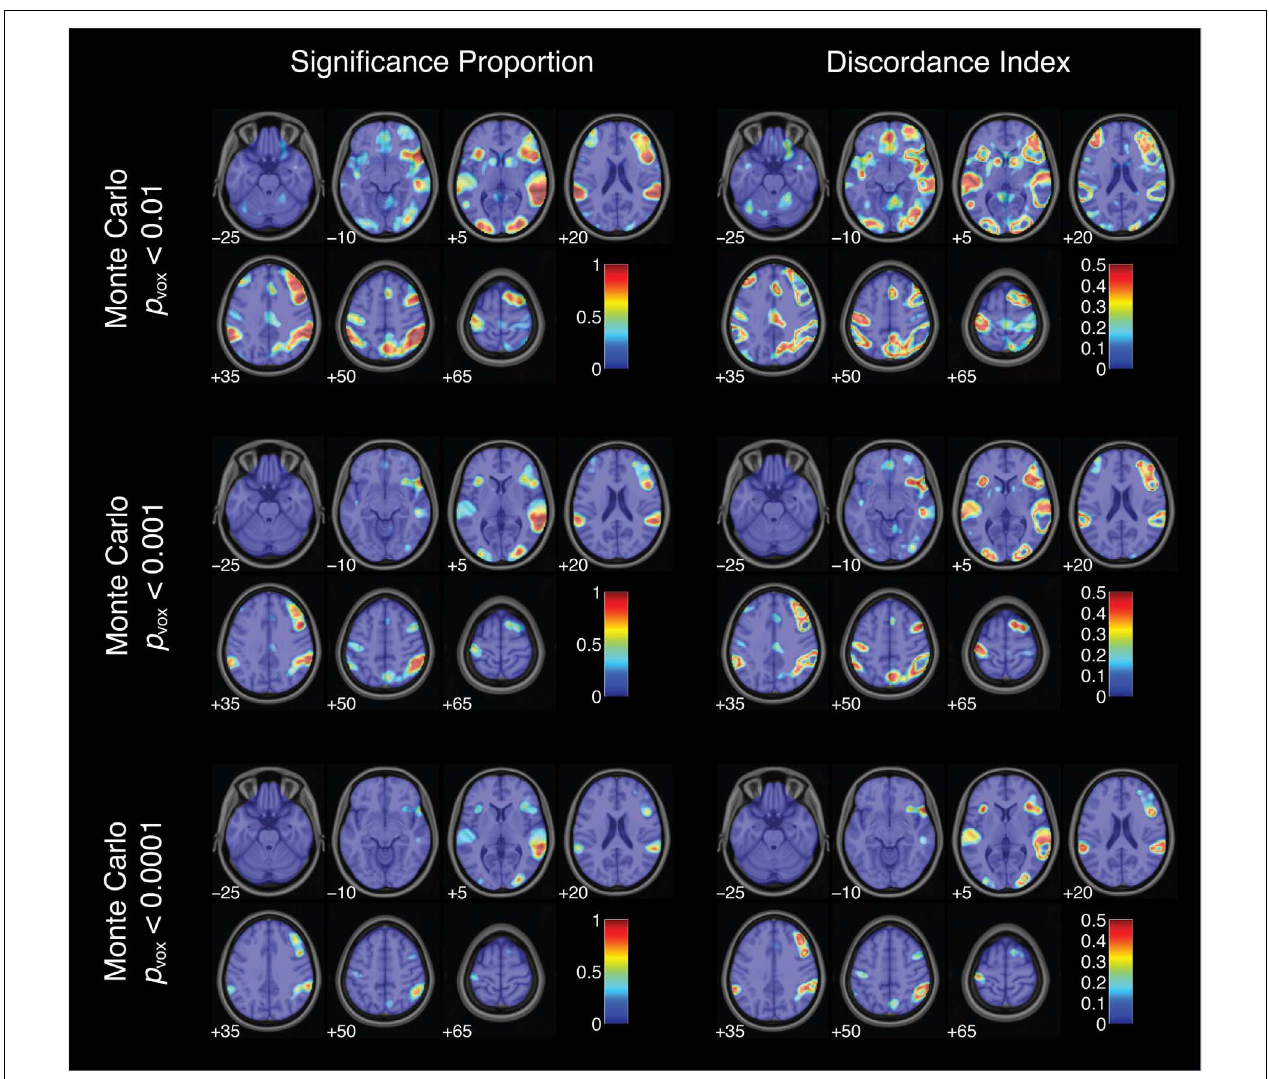
disagreement across threshold maps. Images are presented in neurological orientation, with the left hemisphere displayed on the left. Note that color scales range from 0 to 1 for significance proportion and from 0 to 0.5 for discordance